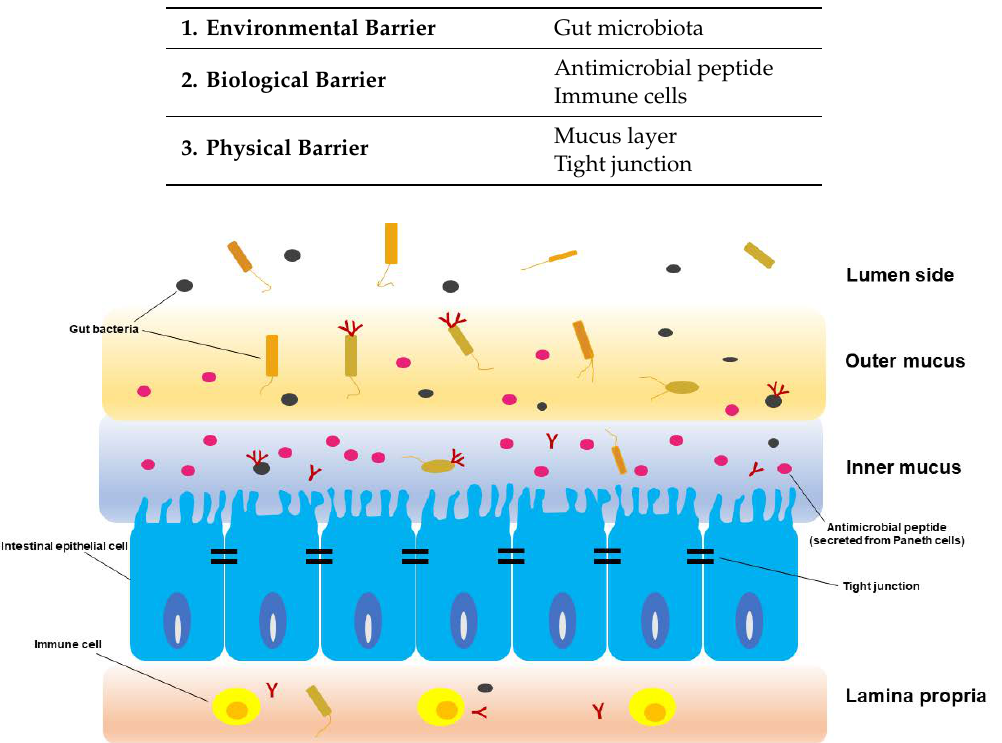
Table 1. Three types of intestinal barrier.